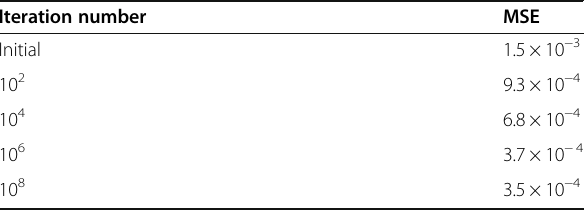
Table 3 MSEs for the 1D ‘ random ’ curve study with noiseless